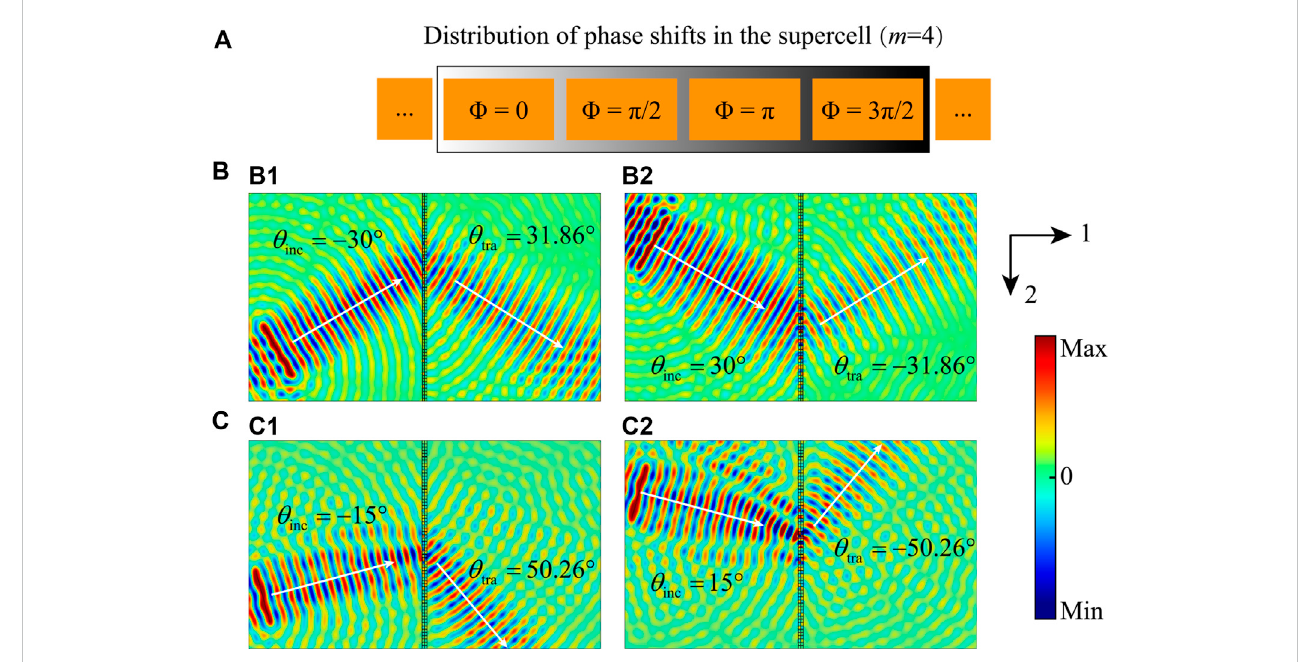
FIGURE 4 (A) Distribution of phase shifts along the supercell with m = 4. Out-of-plane displacement fi elds of (B) ± 30 ° and (C) ± 15 ° incident angles.